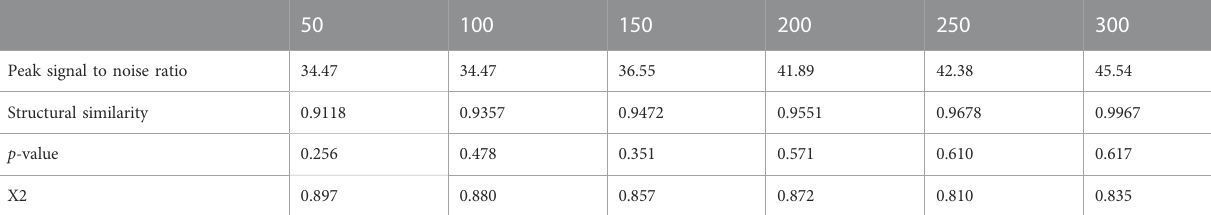
TABLE 7 Optimization results based on deep